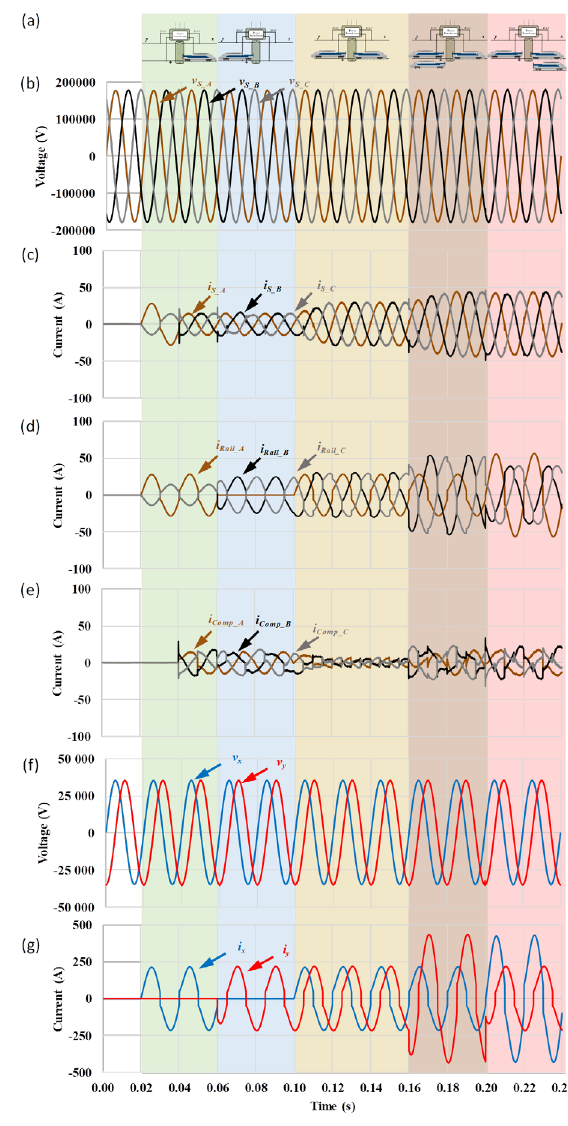
Figure 8. Simulation results of the STATCOM compensating the power quality problems